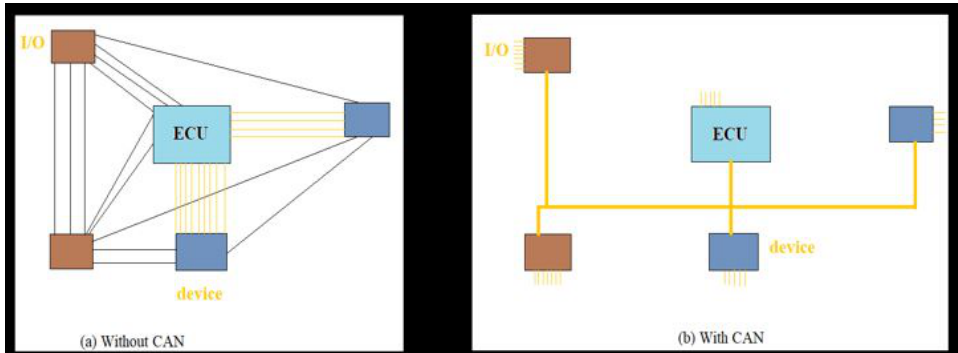
Figure 2. CAN networks significantly reduce wiring.